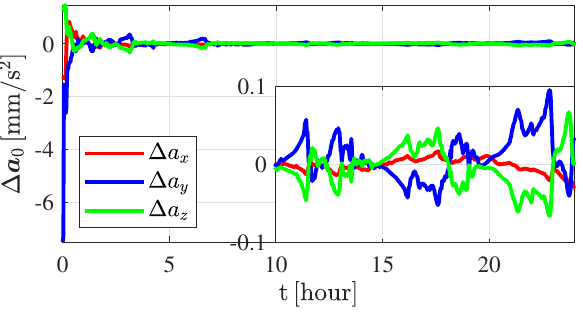
Figure 11. Maneuver estimated errors using the eighth-order polynomials. Table 2. Estimated RMSE of different cases.